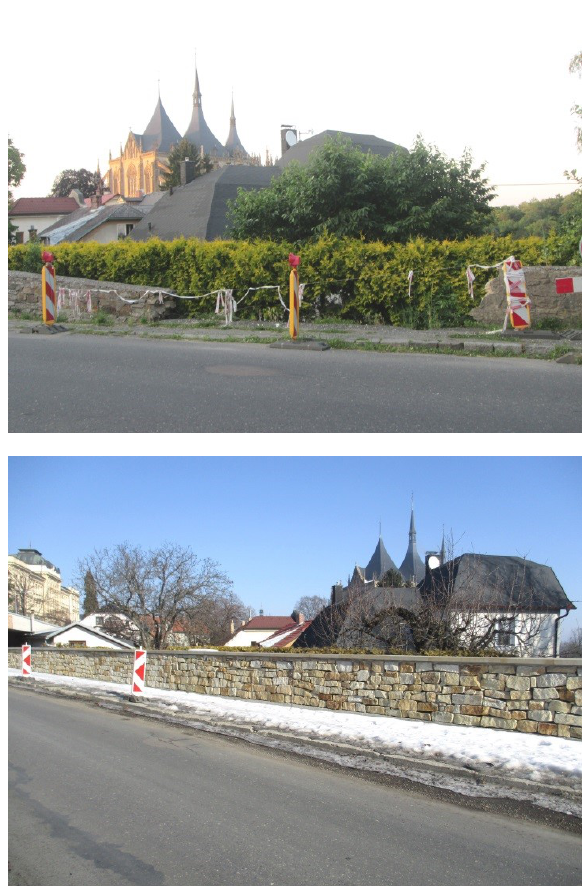
Figure 2. View of the original (top) and new wall (bottom) near St. Barbara’s